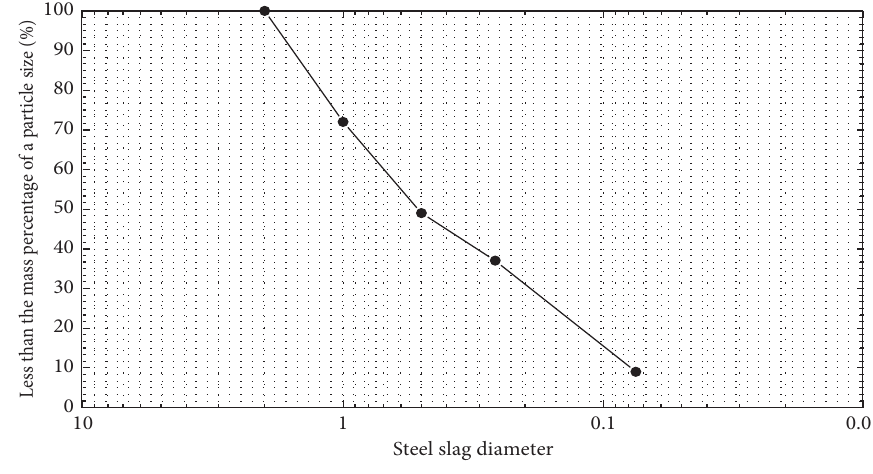
Figure 1: Curve of steel slag Table 1: Physical properties of the test soil.